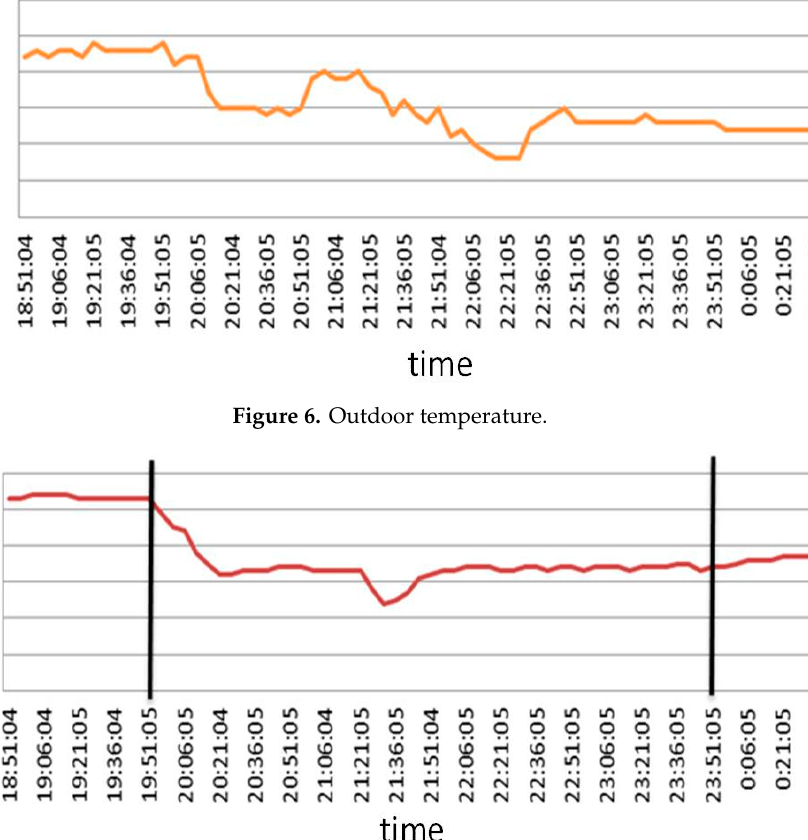
Figure 7. AHU outlet cold air temperature.